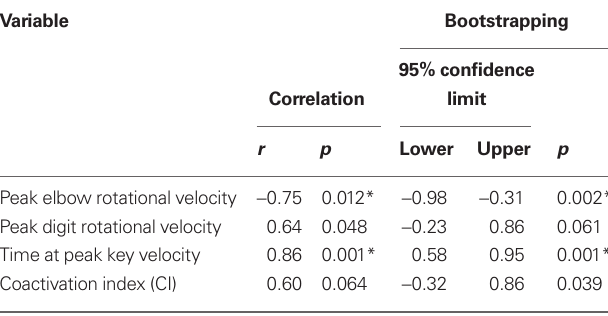
Table 4 | results of correlation analysis between the inter-keystroke interval at the fastest tempo and the movement variables for all